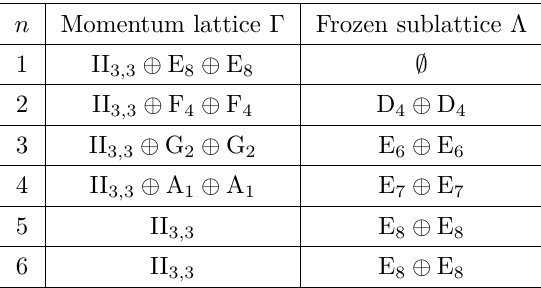
Table 1 . Momentum lattices for the moduli spaces of heterotic Z m -triples and their orthogonal complements Λ in Γ 3 , 19